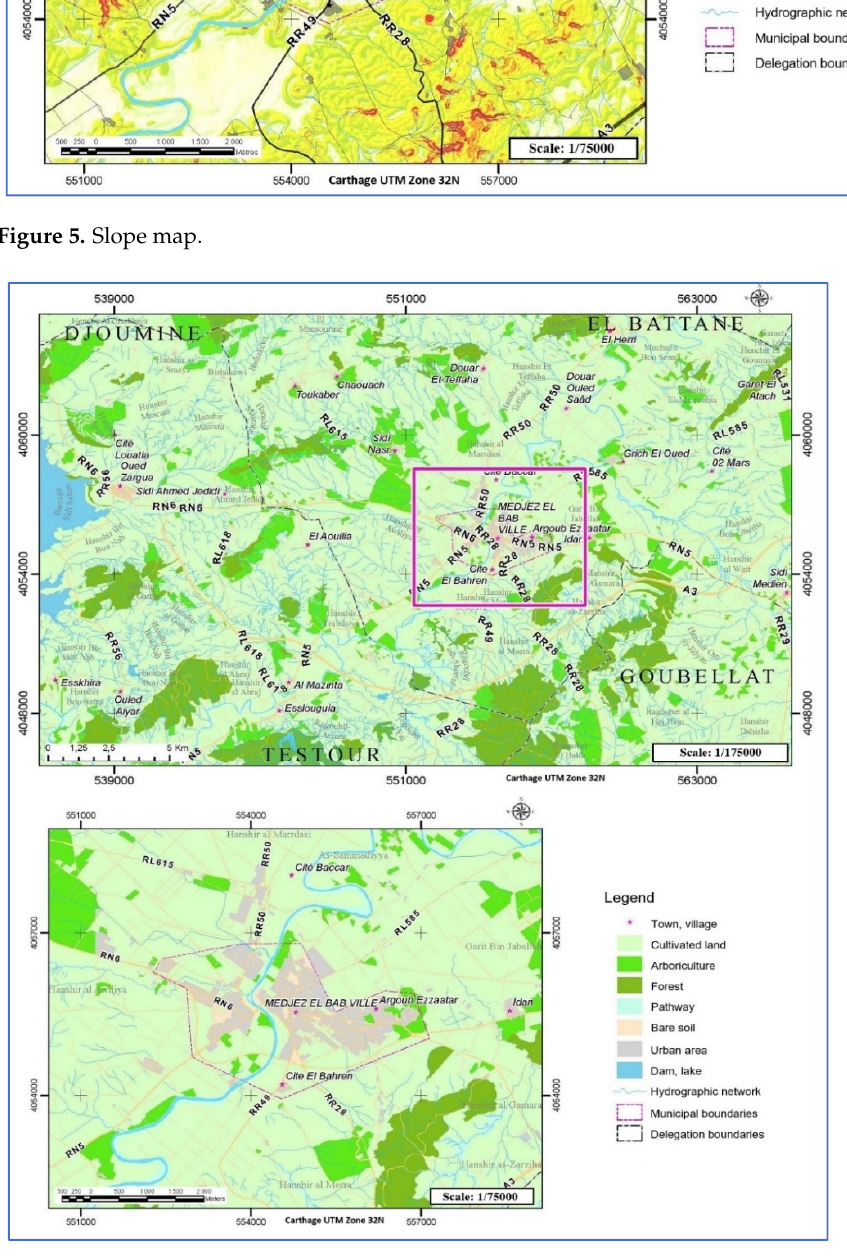
Figure 6. Land use map.